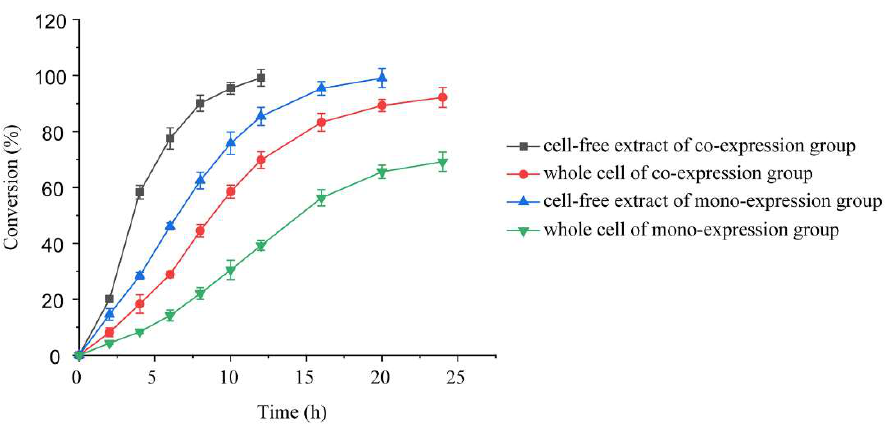
Figure 5. Time courses of asymmetric synthesis of ( S )-NBHP by whole cell and cell-free extract of E. coli /pET28-K-rbs-G (coexpression group) and strains expressing KRED and GDH alone (monoexpression group). All reactions were performed in triplicate, and error bars represent the standard error of the mean.